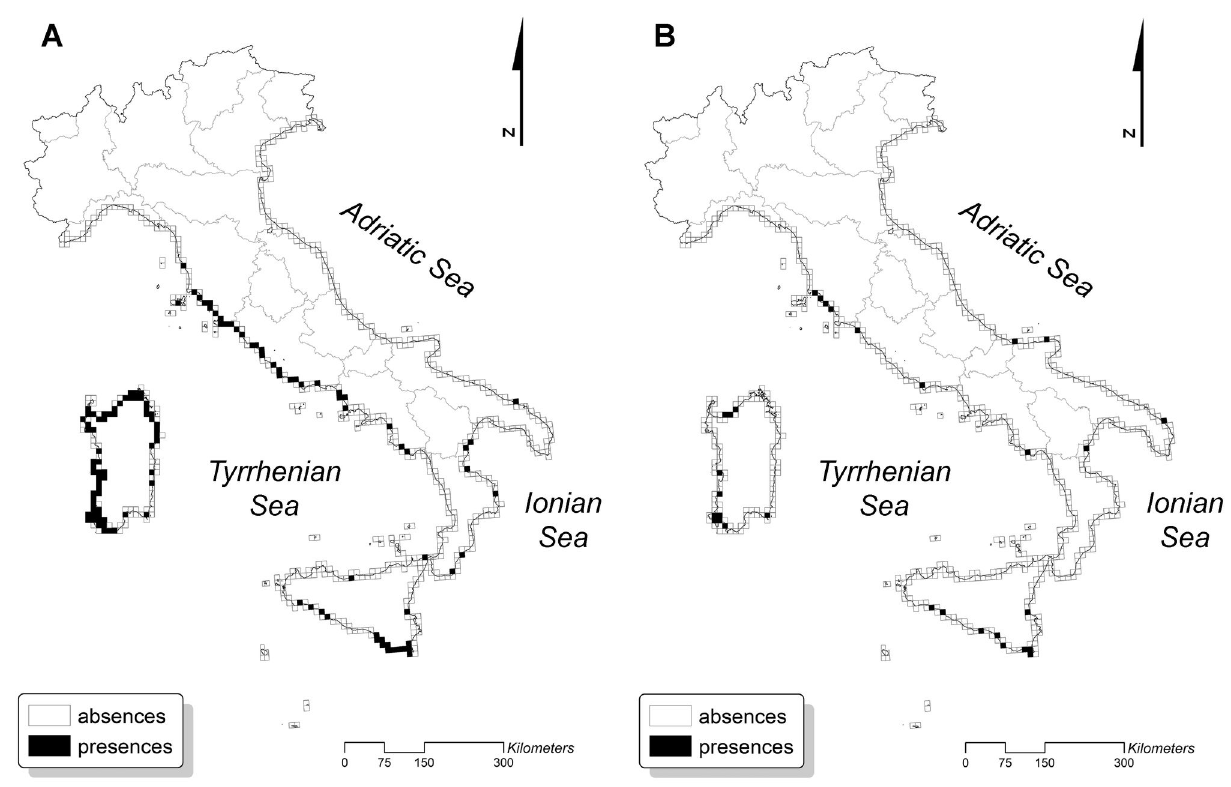
Figure 3. Current and future distribution of fixed dune habitat. ( A ) Current and ( B ) future predicted distribution of one of the fixed dune habitats: the Crucianellion maritimae fixed beach dunes (Habitat 2210) are predicted to lose more than 70% of its current distribution in the near future. As the results of two future scenarios were similar, only the A2 future scenario is shown (details in Tab. 3). doi: